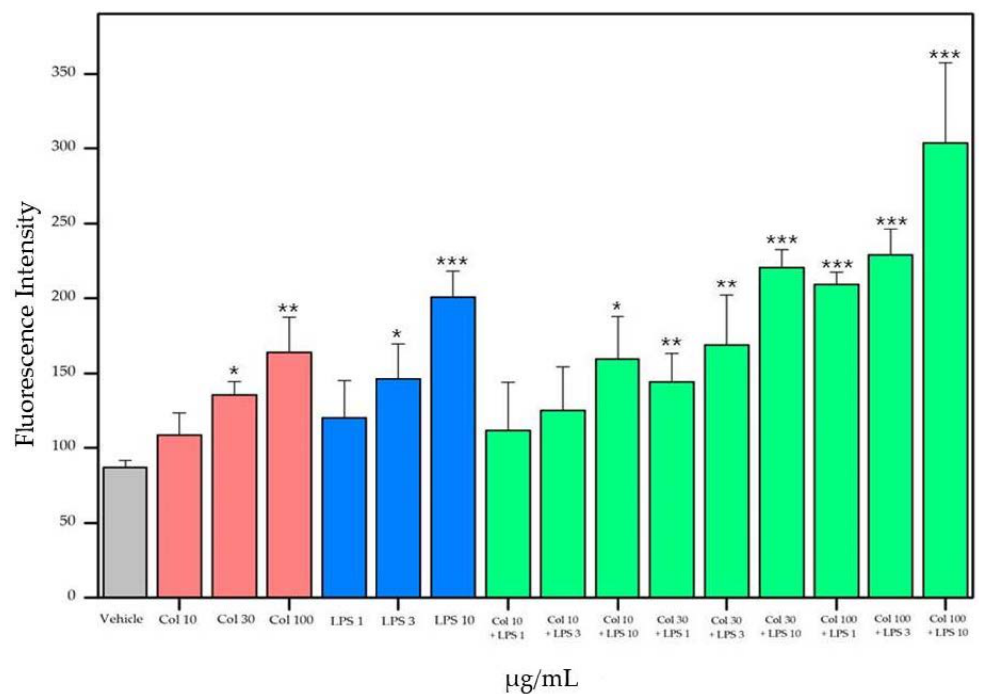
Figure 8. Effect of collagen peptide and LPS on peroxynitrite production in supernatant media without RAW 264.7 cells for 48 h. The values are presented as a mean ± standard deviation. The changes were significantly different between the vehicle and test samples, with p < 0.05 (*), p < 0.01 (**), and p < 0.001 (***).